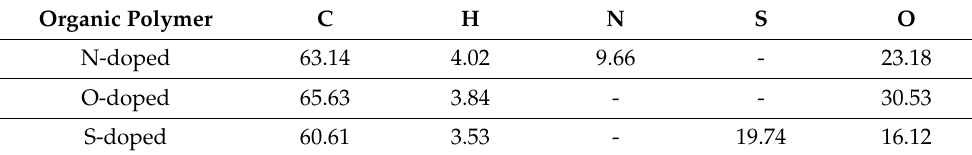
Table 1. Elemental composition (wt.%) of the studied organic polymers. Organic